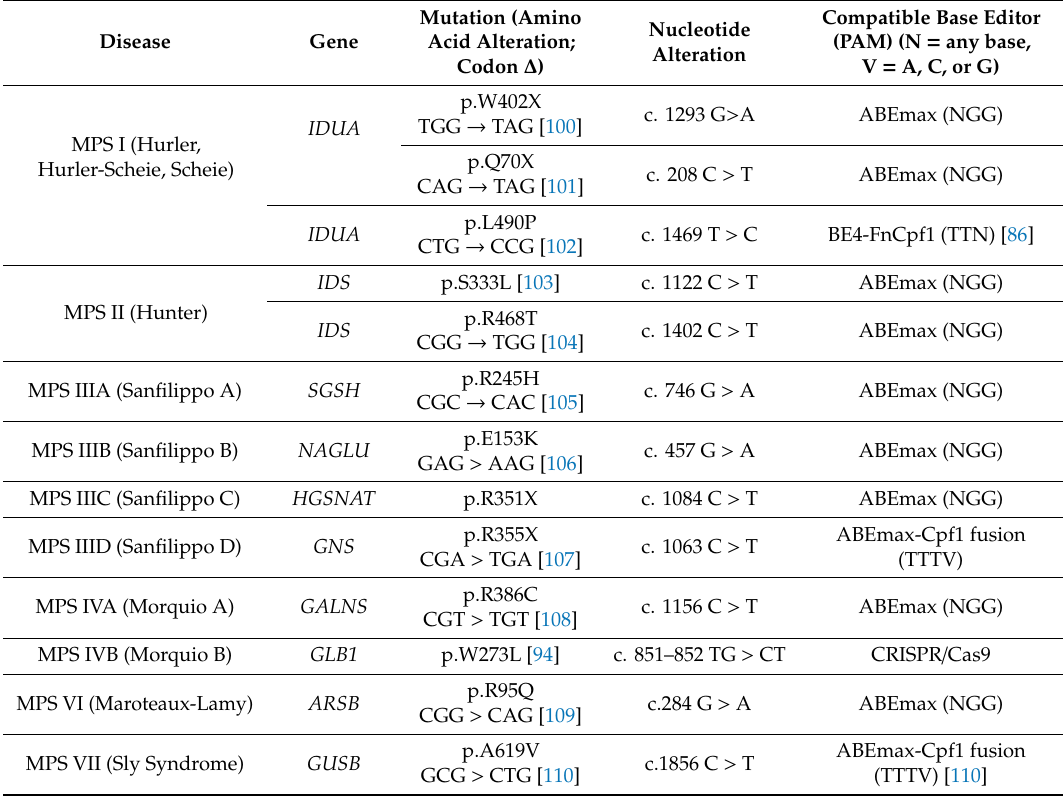
Table 2. Example target mucopolysaccharidosis mutations for base editing *.